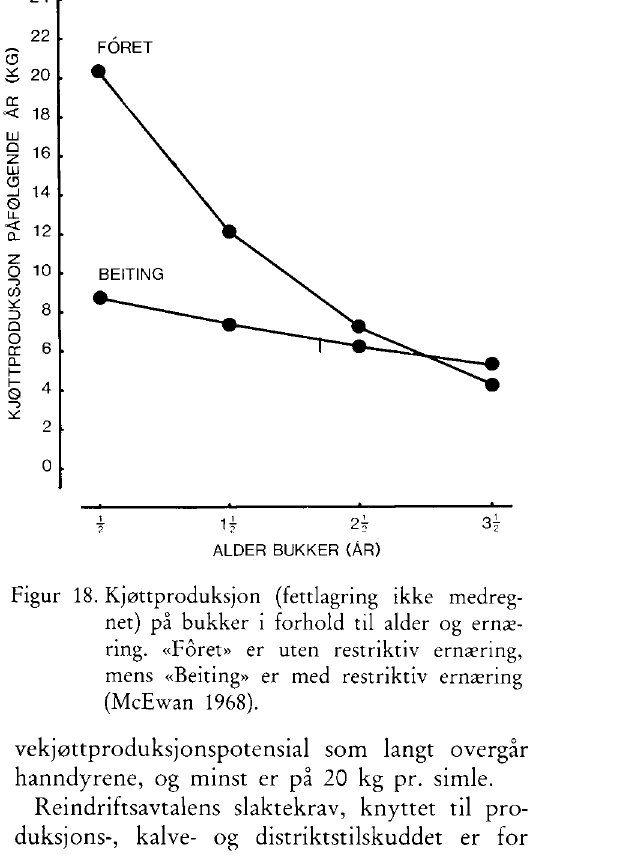
Tabell 3. Beregnet gjennomsnittsvekt og kalvekjøttproduksjonspotensial for tre simleflokker (SAMEBY 1, 2 og 3 i figur 16) med alternativ aldersstruktur (struktur «1975» og «1980» i figur 17).